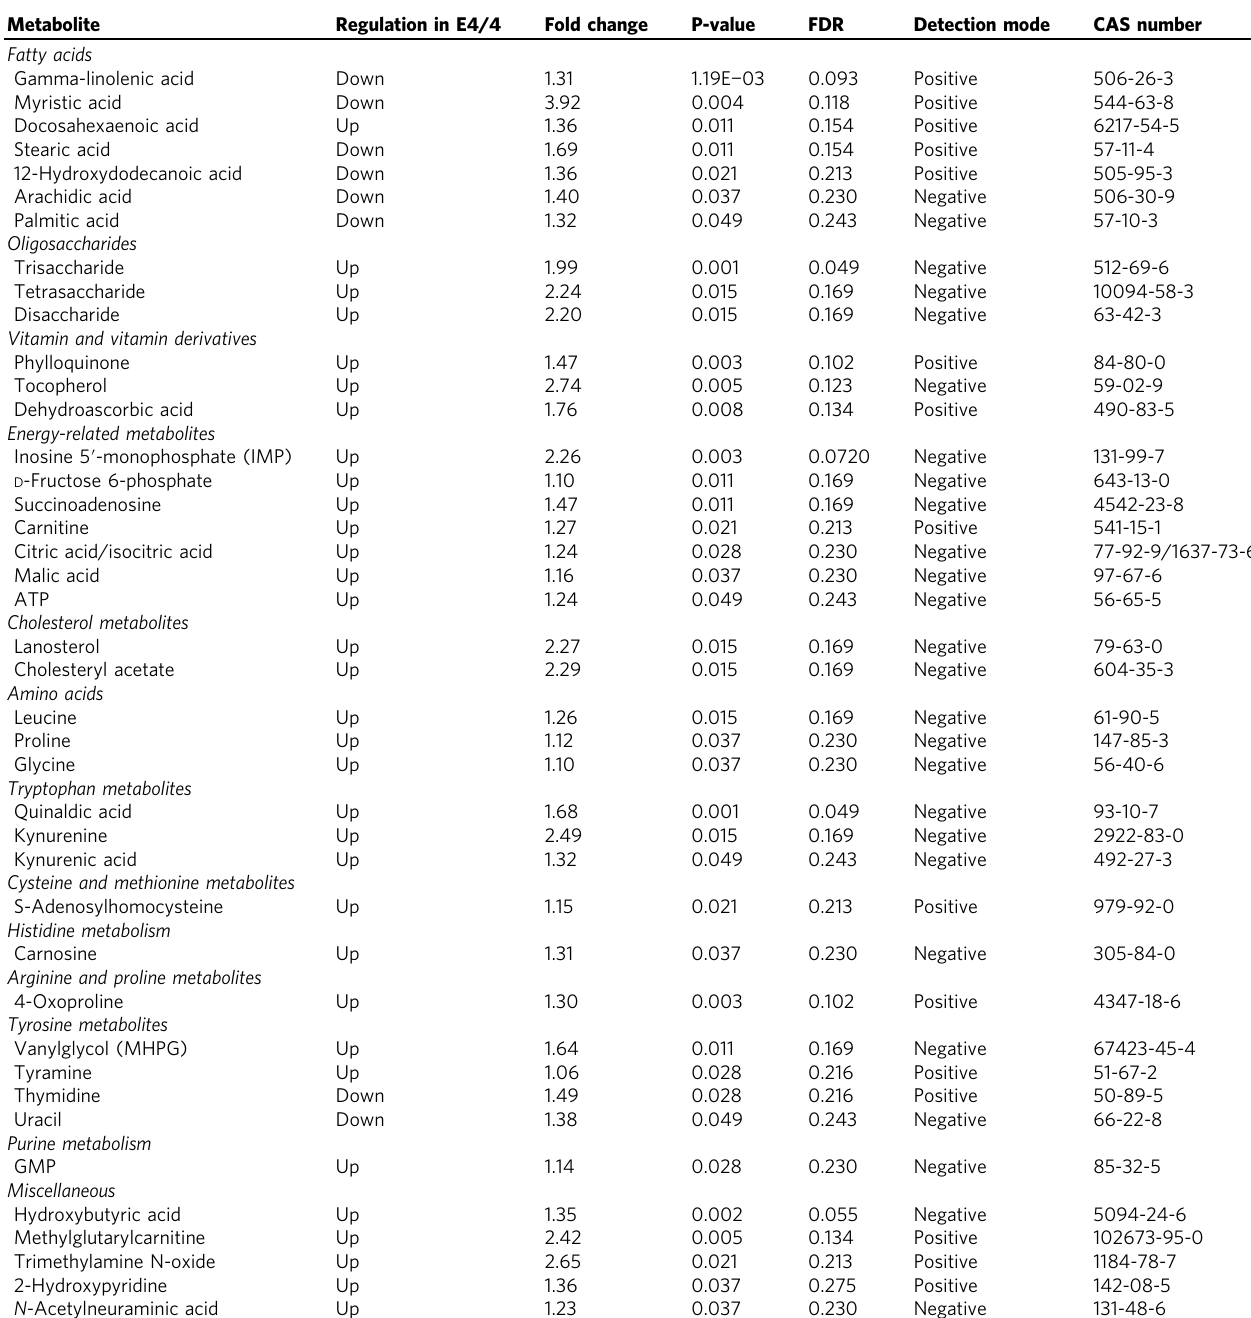
Table 1 Differentially expressed targeted metabolites from the EC of APOE4 vs. APOE3 mice Metabolite Fatty acids Gamma-linolenic